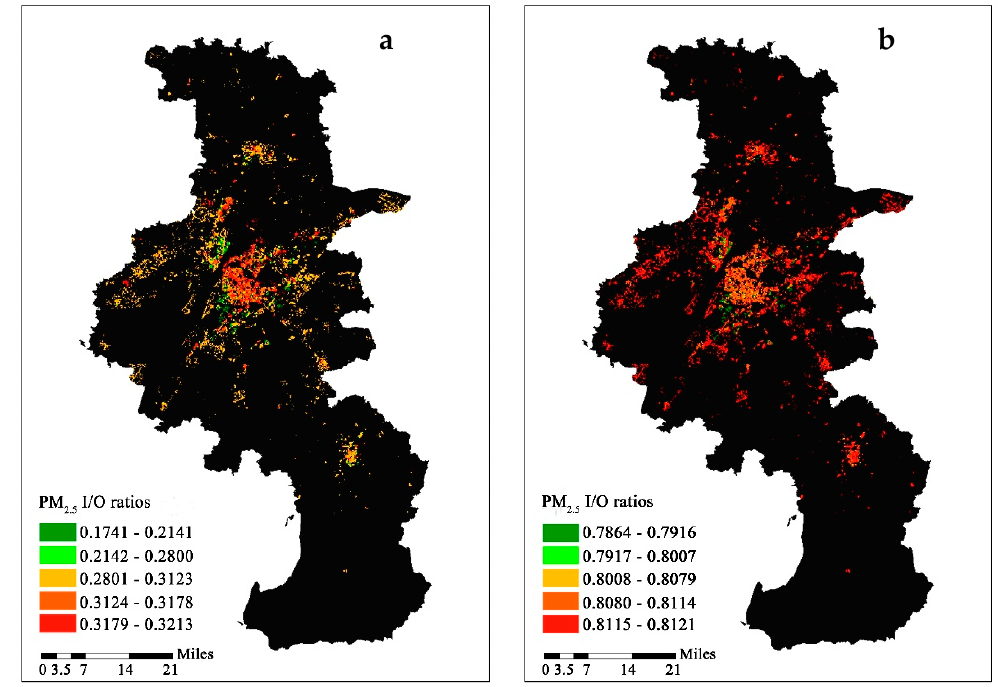
Figure 6. The annual PM 2.5 I/O ratios for residences across Nanjing. ( a ): Scenarios 1, ( b ): Scenarios 2.